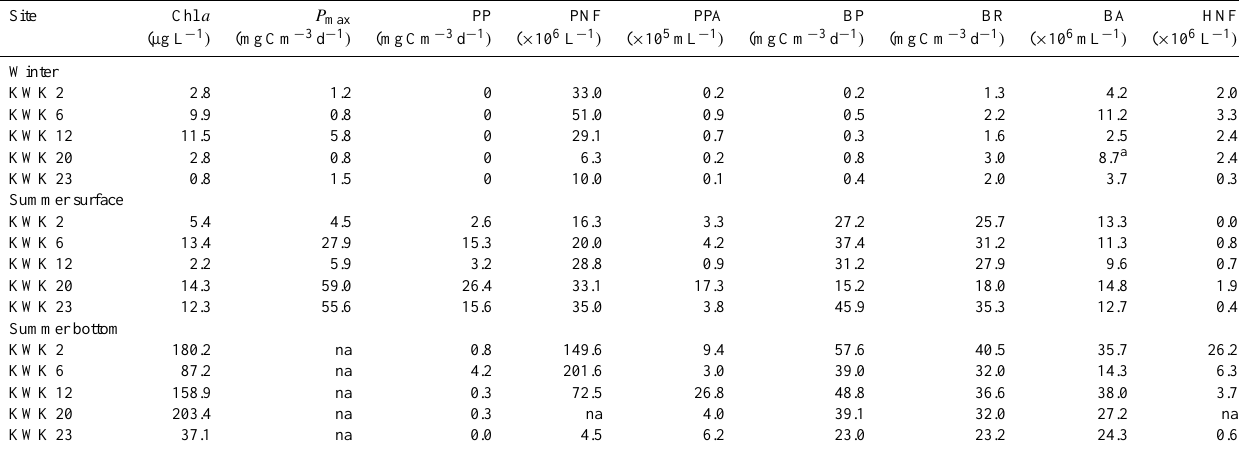
Table 3. Phototrophic and heterotrophic properties of subarctic pond water sampled in late winter and during summer at the surface and bottom of the water column, including chlorophyll a concentration (Chl a) , maximum photosynthesis parameter ( P max ) , in situ primary pro- duction (PP), pigmented nanoflagellate abundance (PNF), phototrophic picoplankton abundance (PPA), bacterial production (BP),